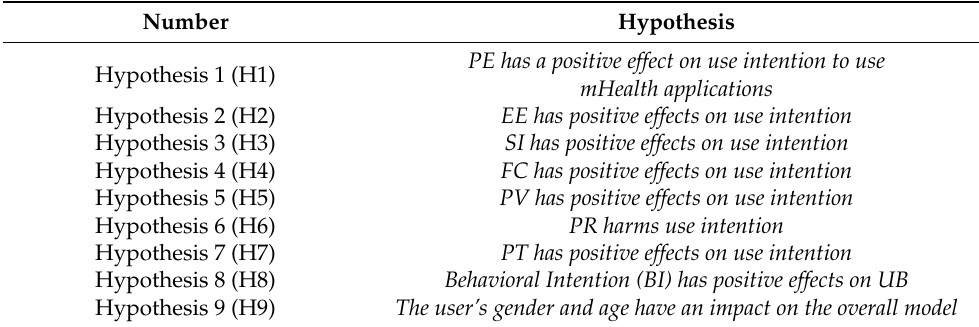
Table 3. Correlated hypothesis of each variable.